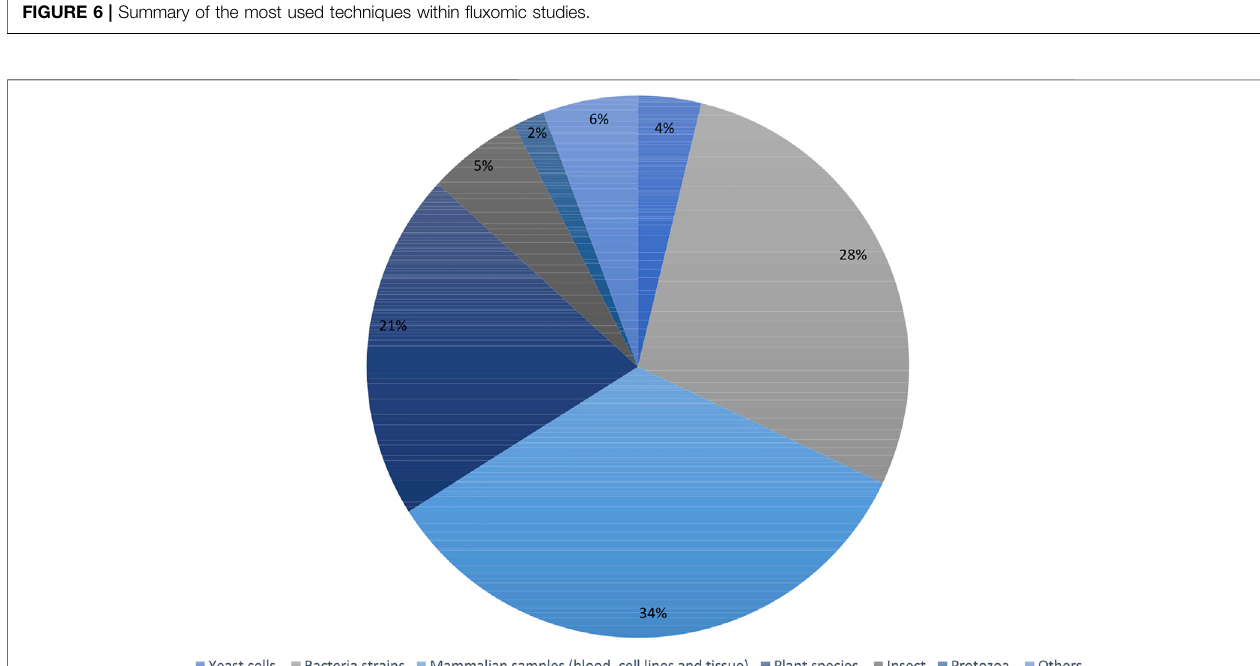
FIGURE 7 | Summary of the most used organisms within fl uxomic studies.